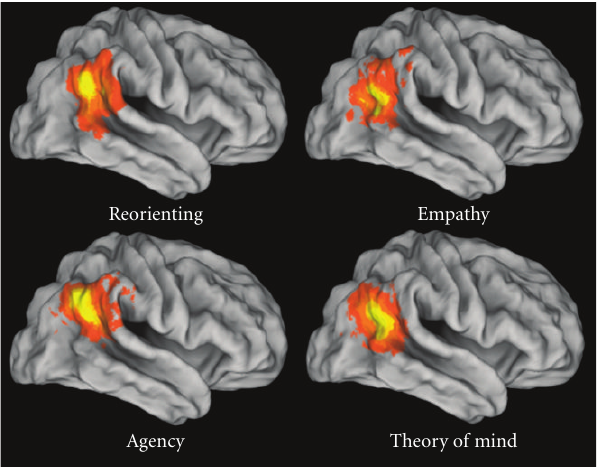
Figure 2: Results of a quantitative meta-analysis of 70 functional neuroimaging studies. Activation likelihood estimation maps in the right temporoparietal junction are shown. Colors code the probability of activation with brighter yellow indicating the highest activation (reprinted with permission from